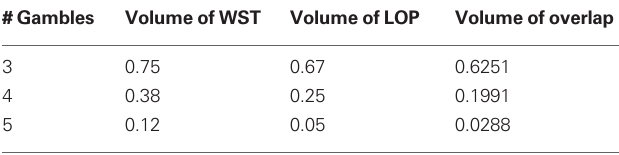
per condition (per